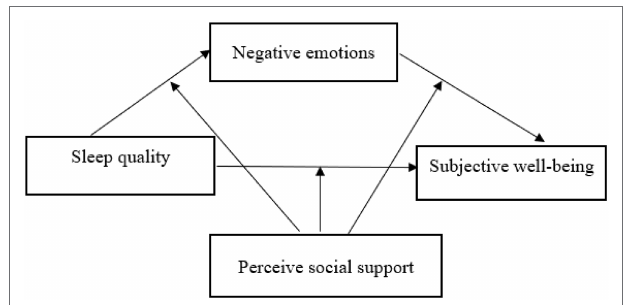
FIGURE 1 | Theoretical model: a moderated mediation